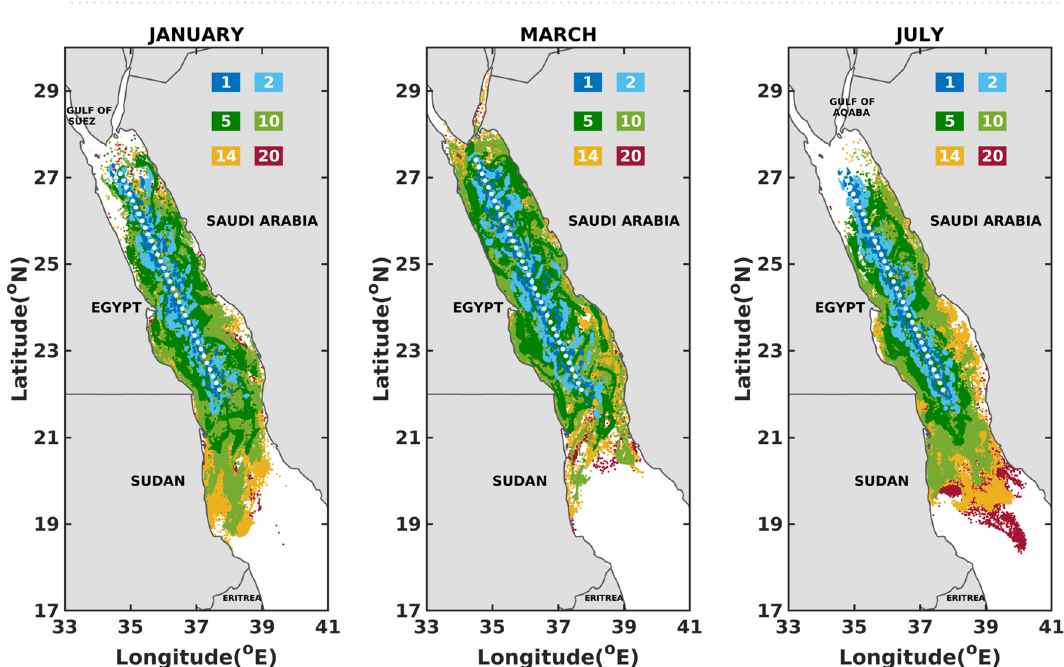
Figure 5. Superposition maps for the one (1), two (2), five (5), ten (10), fourteen (14) and twenty (20) days after the commencement of the spill, in the Northern Red Sea. The figures were created on Matlab-r2020b (https:// matlab- r2020b. softw are. infor mer.